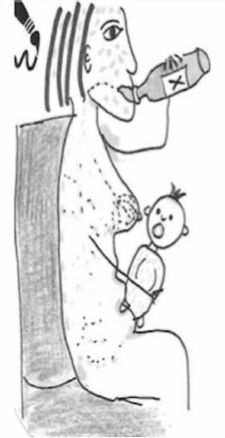
Figure 14. Breastfeeding, university education, primary school teacher.